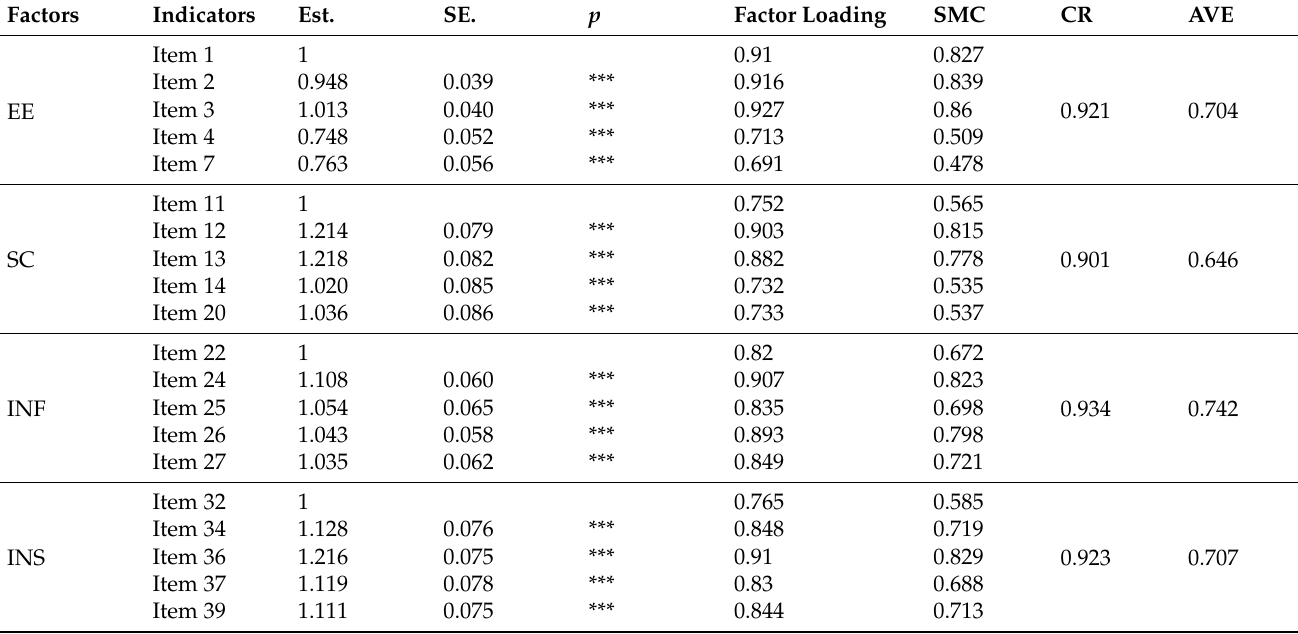
Table 3. Results of CFA among calibration sample.